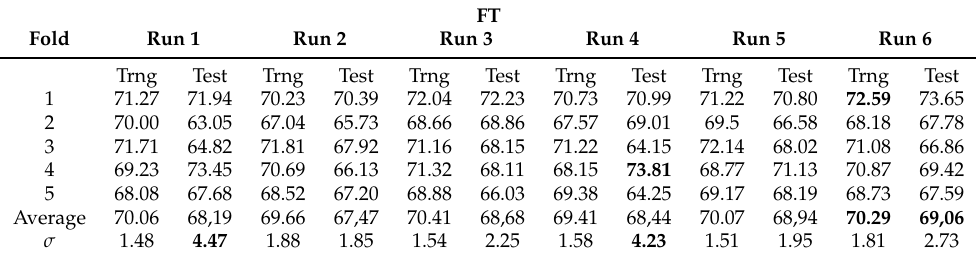
Table 11. Performance of the best individuals of the GBVSBP model for all FT database runs. Each pair of training and testing corresponds to one experiment of the k-fold. Therefore, we obtain 30 executions of our system and report the standard deviation for each run